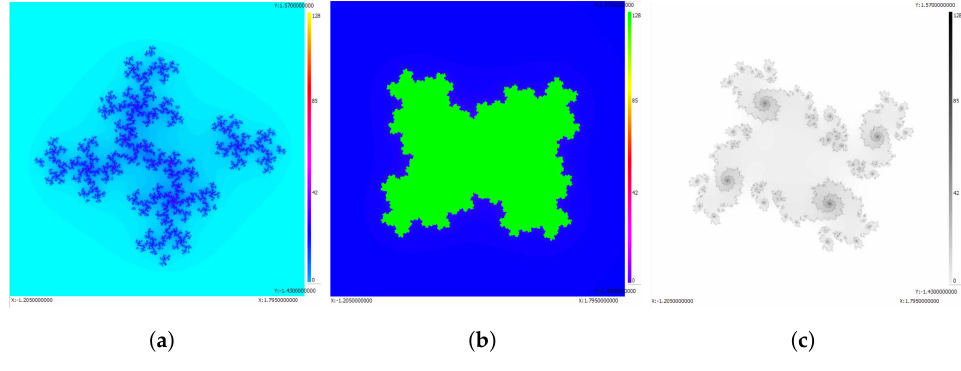
Figure 6. Various shapes of Julia sets for B 4,0.5 ( x ) iterating 128 times. ( a ) c = − 0.535 − 0.27 i ;